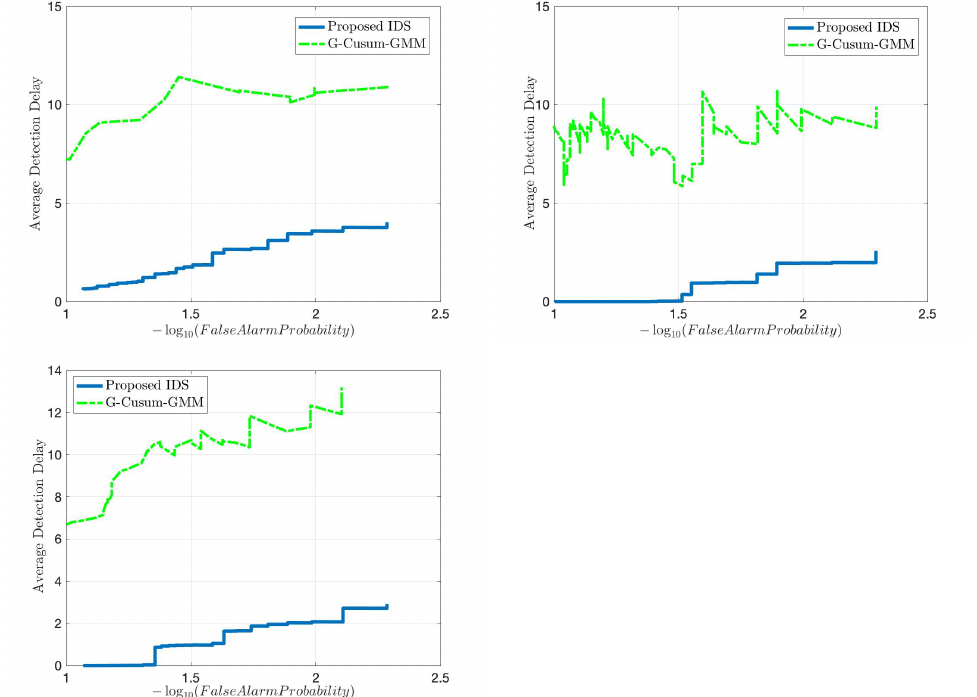
Figure 6. Comparison in terms of quick and accurate detection between the proposed detector and an idealized version of the state-of-the-art sequential detector (G-CUSUM), which exactly knows the attack magnitudes under different FDI attack scenarios: speed anomaly (top left), position (easting) anomaly (top right), direction anomaly